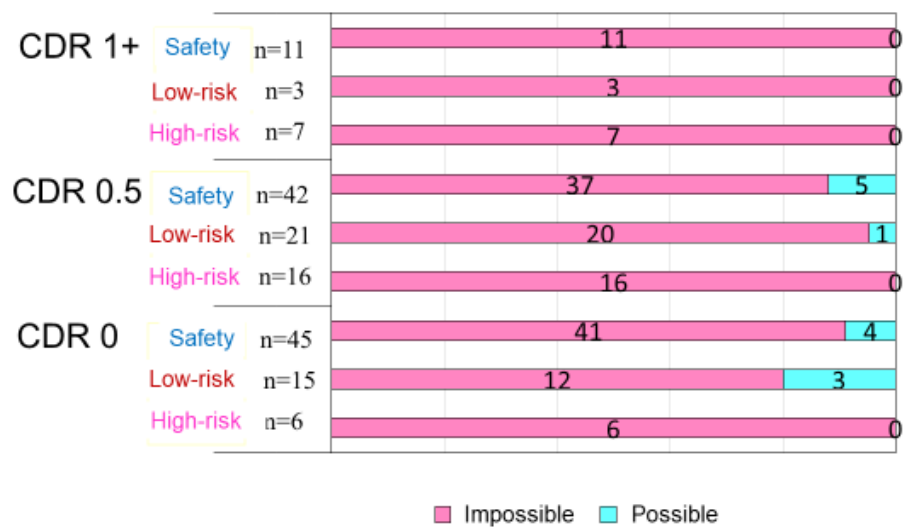
Figure 2. Relationship beteween the risks of fire accidents and Induction Heating operation tasks with the Clinical Dementia Rating